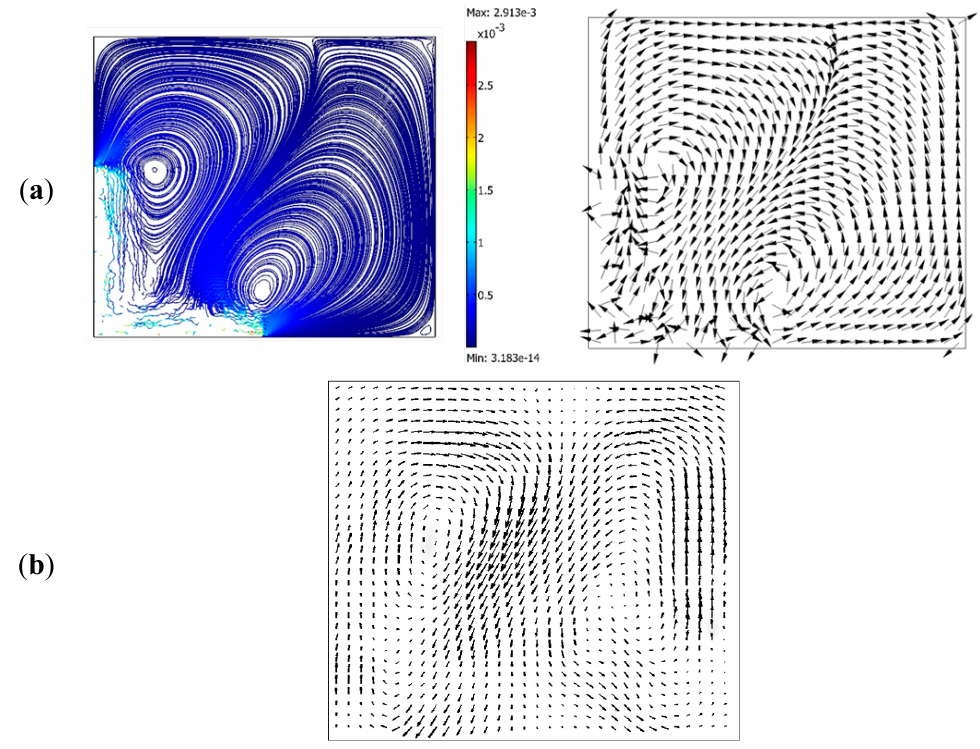
Figure 7. ( a ) Velocity magnitude (m/s) with streamlines ( left ) and flow vectors ( right ), in the 8 mm width × 7 mm height cuvette with two 4 mm length transducers, considering a 24 Vpp and 34.2 MHz oscillatory excitation, after a stationary simulation of the second order Navier- Stokes equations. ( b ) Experimental flow vectors obtained in